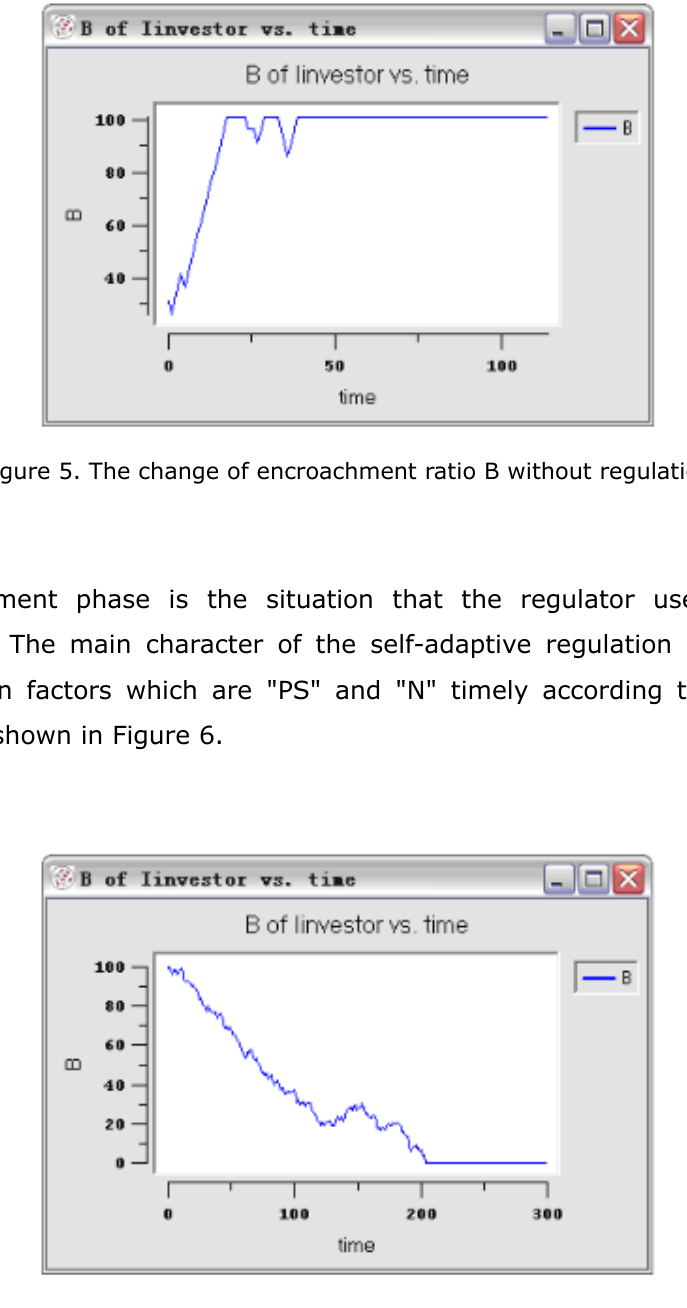
Figure 6. The change of encroachment ratio B with self-adaptive